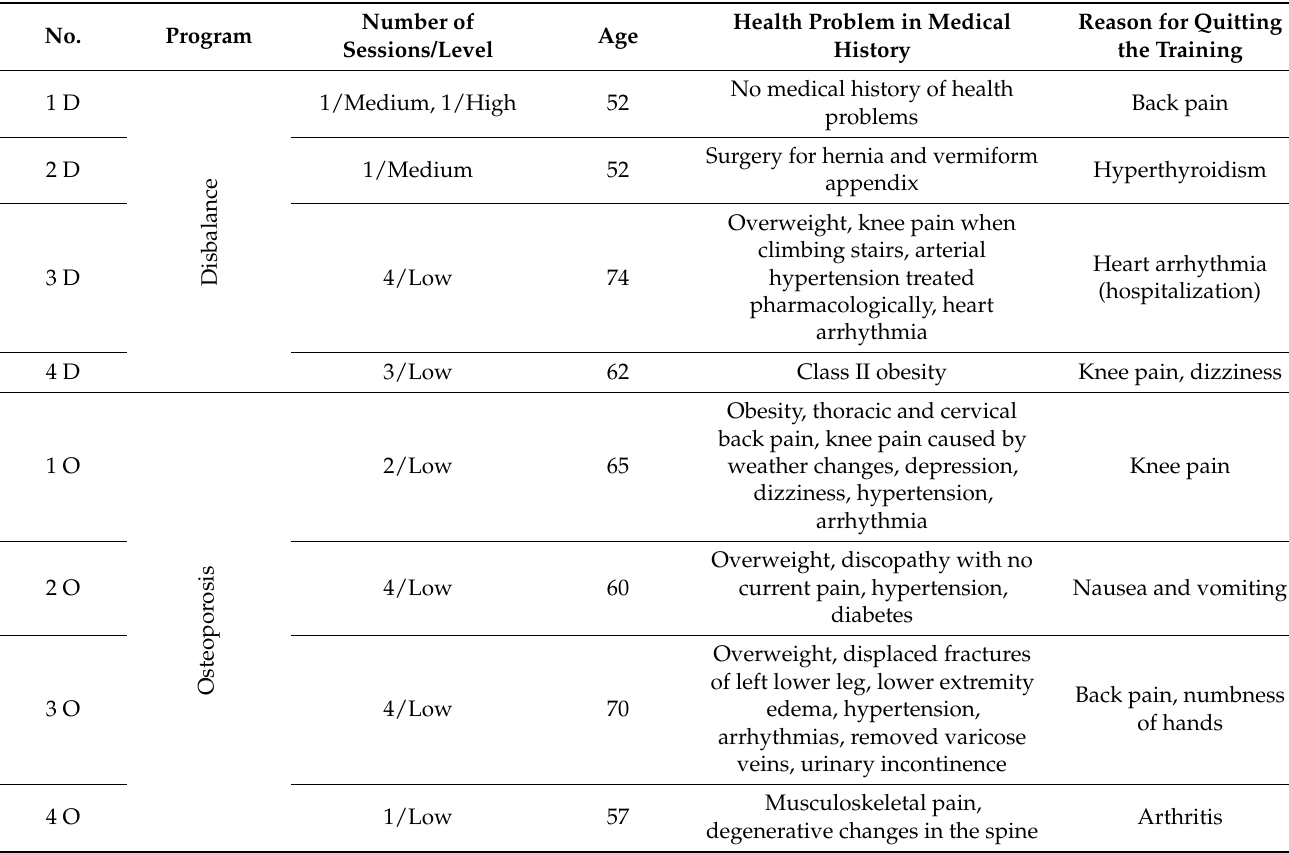
Table 1. Information about women quitting SR-WBV training. N = 8 (12% of all